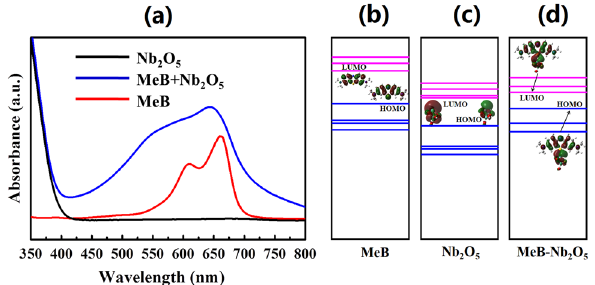
Fig. 4 a The UV-vis optical absorption spectrum of pure Nb 2 O 5 powders, MeB modi fi ed Nb 2 O 5 powders and MeB aqueous solution. b – d The molecular orbital illustrations of the molecule, Nb cluster and MeB-(Nb 2 O 5 ) 2